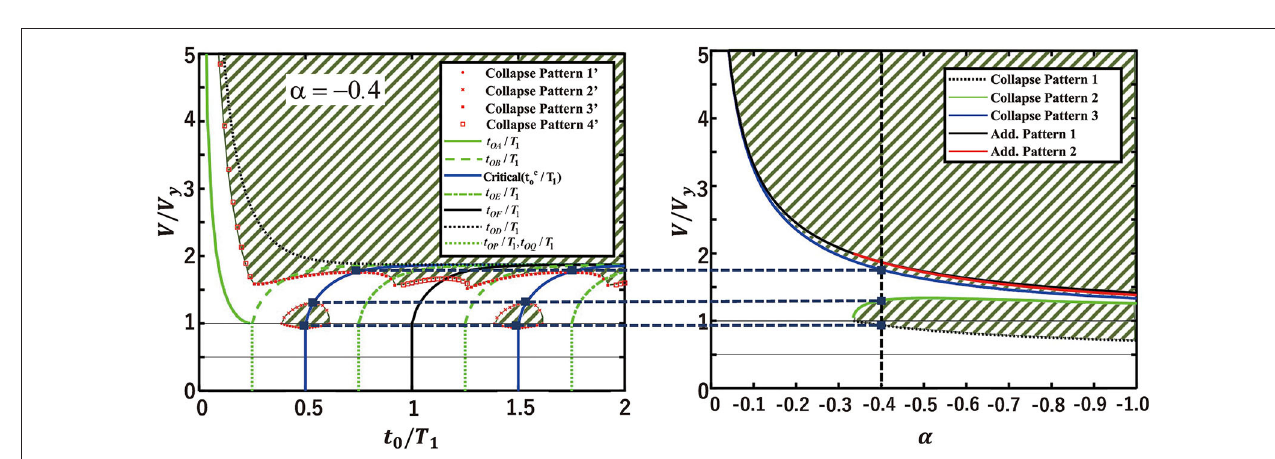
FIGURE 12 | Correspondence between arbitrary timing and critical timing of second impulse in collapse velocity level ( α